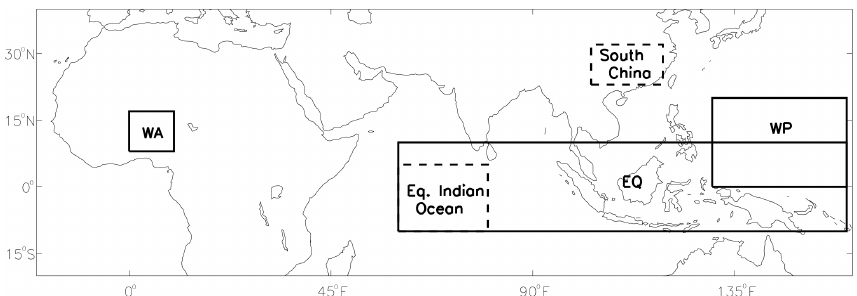
Figure 1. Map illustrating the regions used in this study. “WA”: western Africa; “WP” western Pacific; “EQ”: equatorial region. See text for further